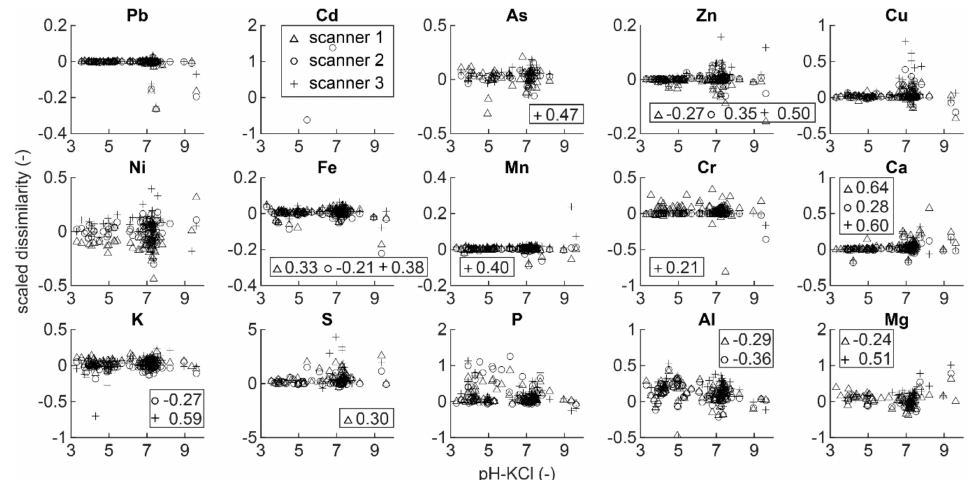
Figure 9. E ff ect of pH-KCl on X-ray fluorescence (XRF) performance. Scatterplots of the scaled dissimilarities for all samples and all scanners versus the samples’ pH-KCl values. Significant (5% significance level) Spearman correlations between the scaled dissimilarities and the pH-KCl are shown for each